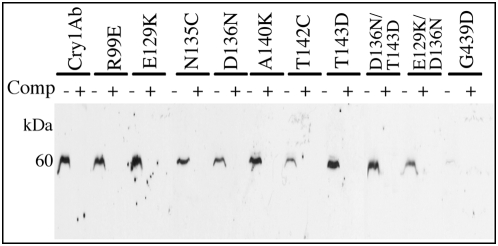
Binding competition assays of Cry1Ab mutants to BBMV of Manduca sexta larvae.Binding of biotin labeled toxins was analyzed in the absence (lanes −) or in the presence (lanes +) of 500-fold molar excess of unlabeled toxin. The biotinylated toxins bound to the vesicles, were visualized with streptavidin-HRP conjugate. The Cry1Ab and all mutants located in domain I (helices α-3 or α-4) bound specifically to BBMV only mutant G439D was affected in binding to the M. sexta BBMV.